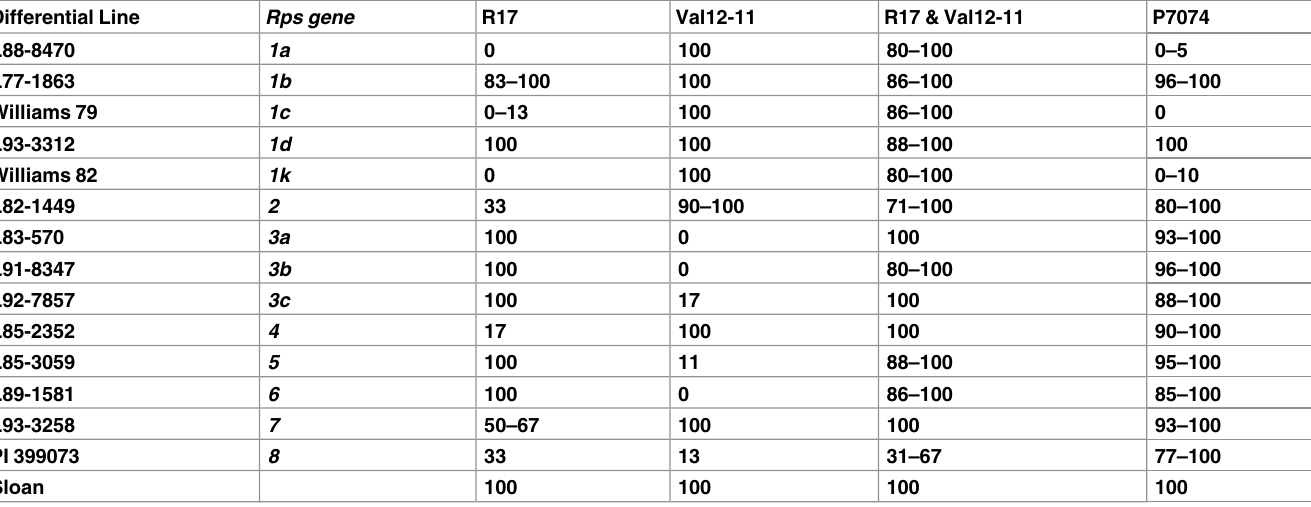
Table 1. Reactions of soybean differentials carrying Rps1a , 1b , 1c , 1d , 1k , 2 , 3a , 3b , 3c , 4 , 5 , 6 , 7 , and 8 genes to Phytophthora sojae isolates. Differential